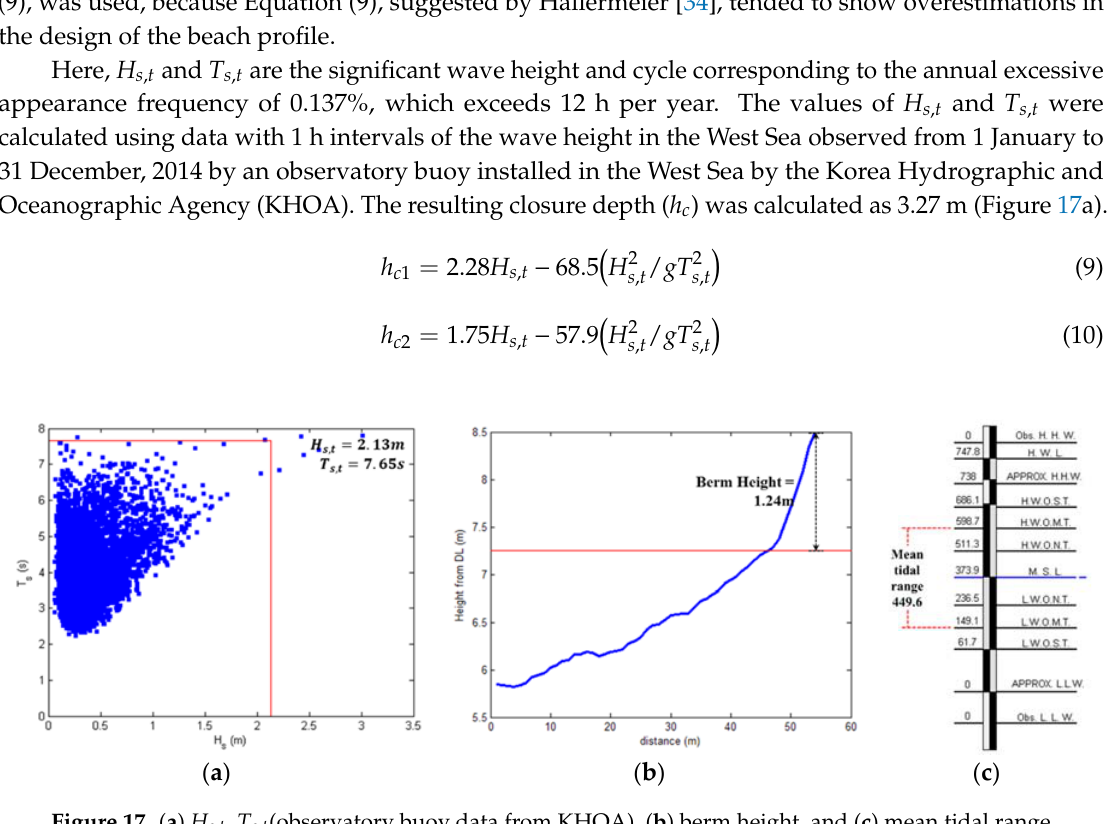
Figure 17. ( a ) 𝐻 (cid:3046),(cid:3047) , 𝑇 (cid:3046),(cid:3047) (observatory buoy data from KHOA), ( b ) berm height, and ( c ) mean tidal range in Janghang. in